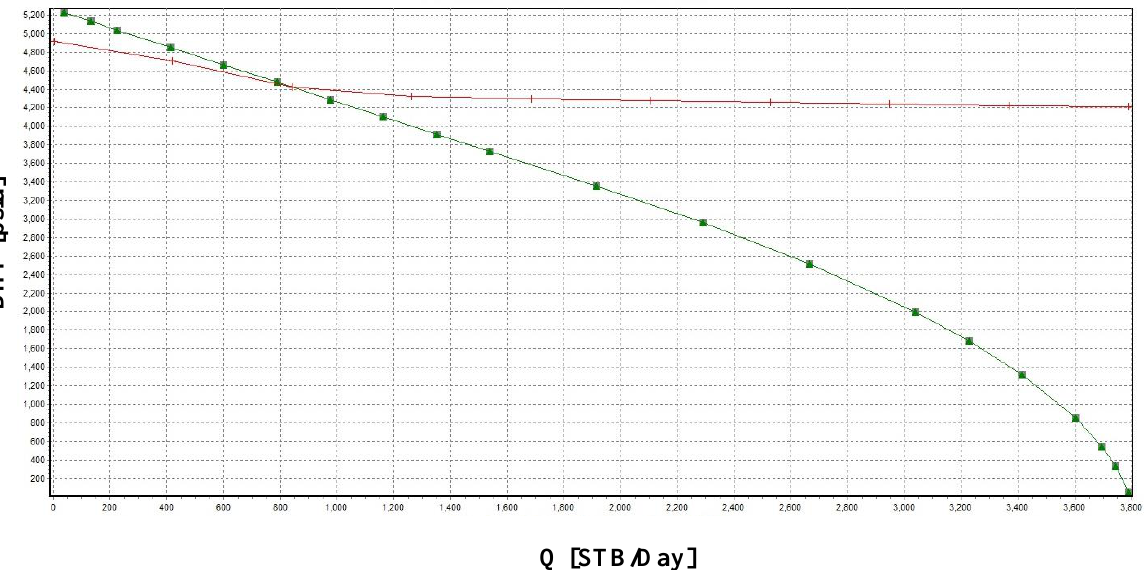
Figure 13. Production conditions before the hydraulic fracturing.